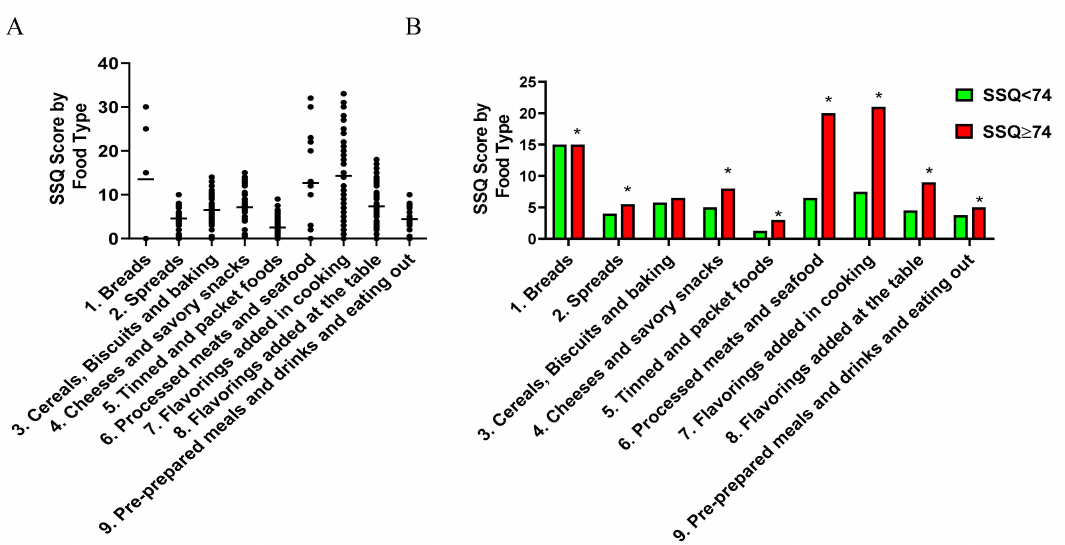
Figure 4. Characteristics of sodium-rich food types in the study population according to absolute SSQ score values. Panel ( A ) shows the absolute scores for each sodium-rich food group for the total study population ( n = 75) and Panel ( B ) shows the median percentage scores divided into groups that had SSQ score < 74 (green) ( n = 34) and SSQ score ≥ 74 (red) (n = 41). * p < 0.05 compared to SSQ <